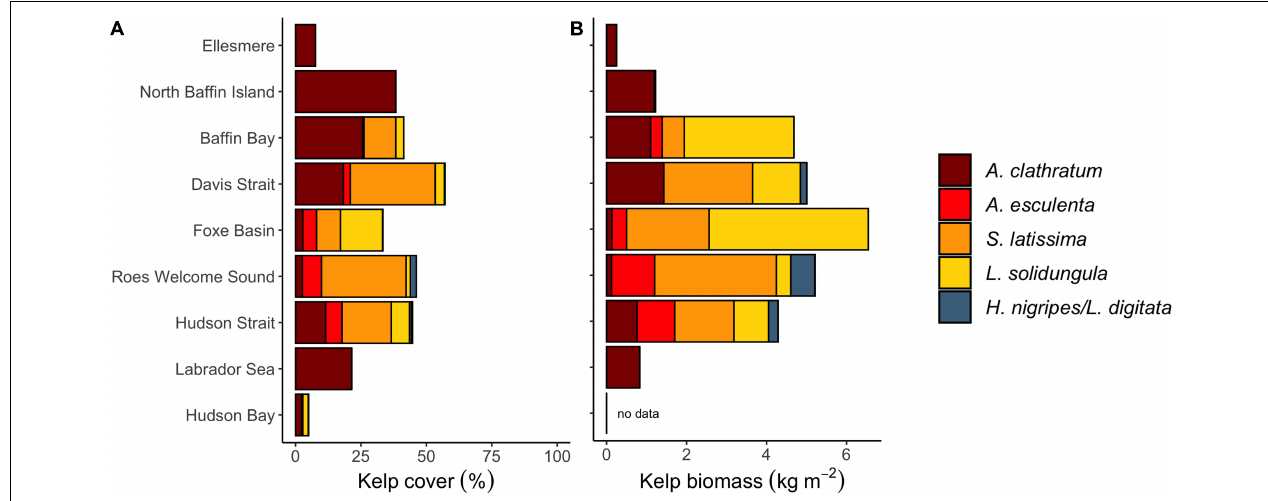
FIGURE 2 | Average percent canopy cover (A) and biomass (B) of kelp species in different regions, averaged across depth and then site. Total bar length is total kelp cover or total biomass. Note biomass was only sampled at a subset of sites with percent cover